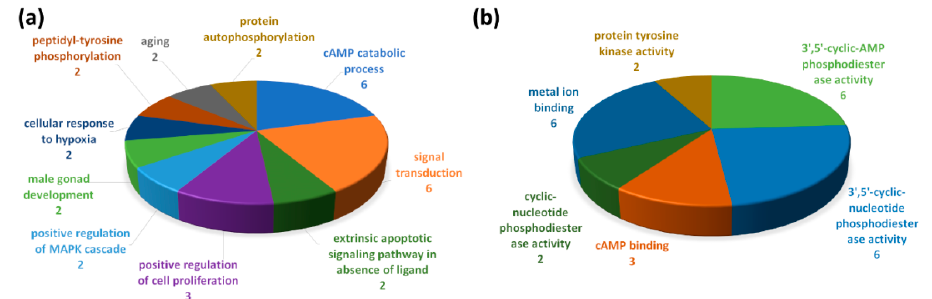
Figure 5. Gene ontology (GO) analyses using the Database for Annotation, Visualization and Integrated Discovery (DAVID) about the putative targets of miR-10a-5p and miR-146a-5p which were significantly down-regulated in bronchial epithelial cells from both asthma and COPD patients. Arabic numerals represent numbers of genes in the ( a ) biological process and ( b ) molecular function.